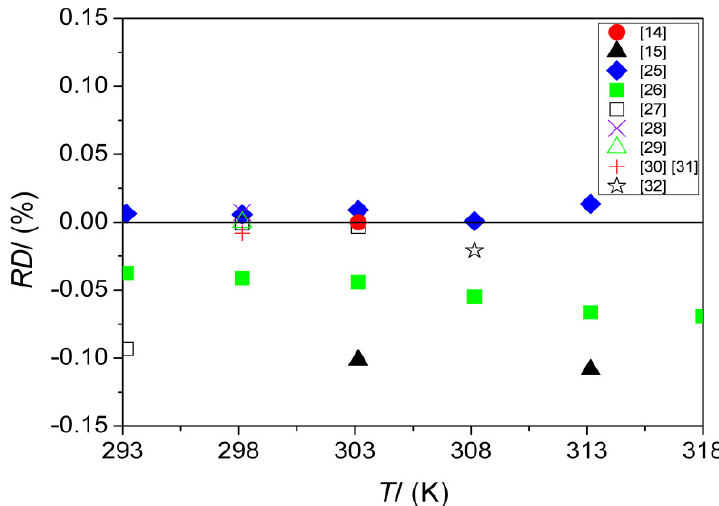
Figure 1. Comparison of the speed of sound in 1-butanol as a function of temperature under atmospheric pressure obtained in this work ( u this work ) with the literature values ( u lit ) [14,15,25–32] presented as relative deviations RD s ( RD / % = 100 · ( u this work − u lit ) / u this work ).